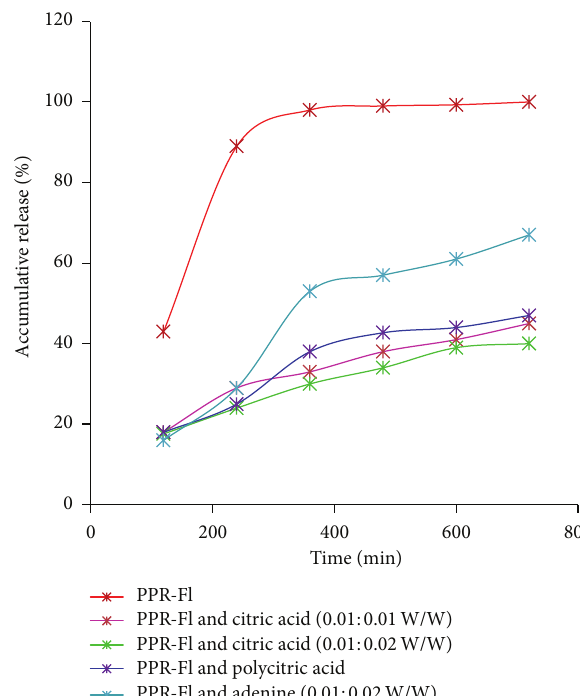
Figure 6: The rate of release of the secondary drug delivery system (cyclodextrin-fluorescein conjugates) from the primary drug delivery system in pH 7.4.